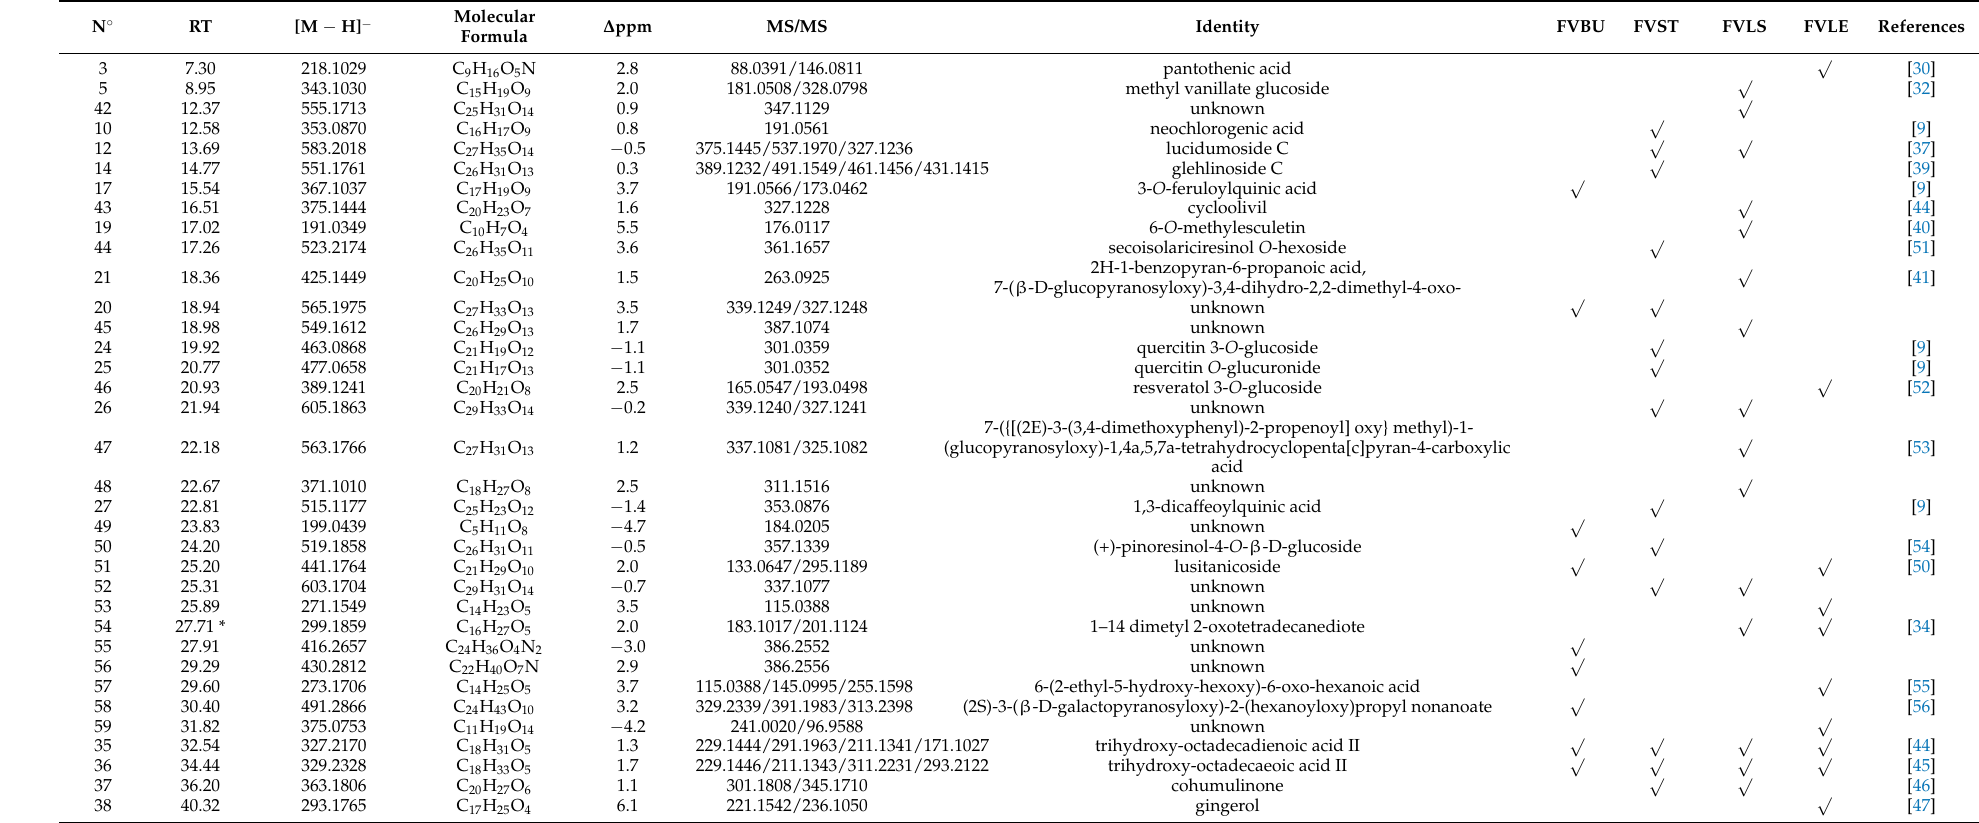
Table 2. Metabolites identified in F. vulgare waste decoctions by LC-ESI/LTQOrbitrap/MS and LC-ESI/LTQOrbitrap/MS/MS analysis. If the compound is present in several parts of the fennel, the RT is referred to as the profiles of FVST, except for the compounds with * which are referred to as the profiles of FVLE. N